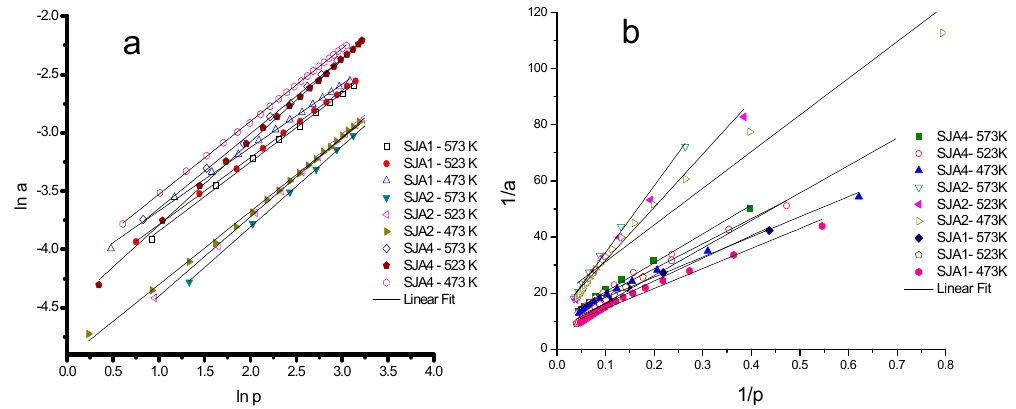
Figure 5. Linear fit of ( a ) the Freundlich model and ( b ) the Langmuir model for the CO 2 adsorption in soils. Figure 5.